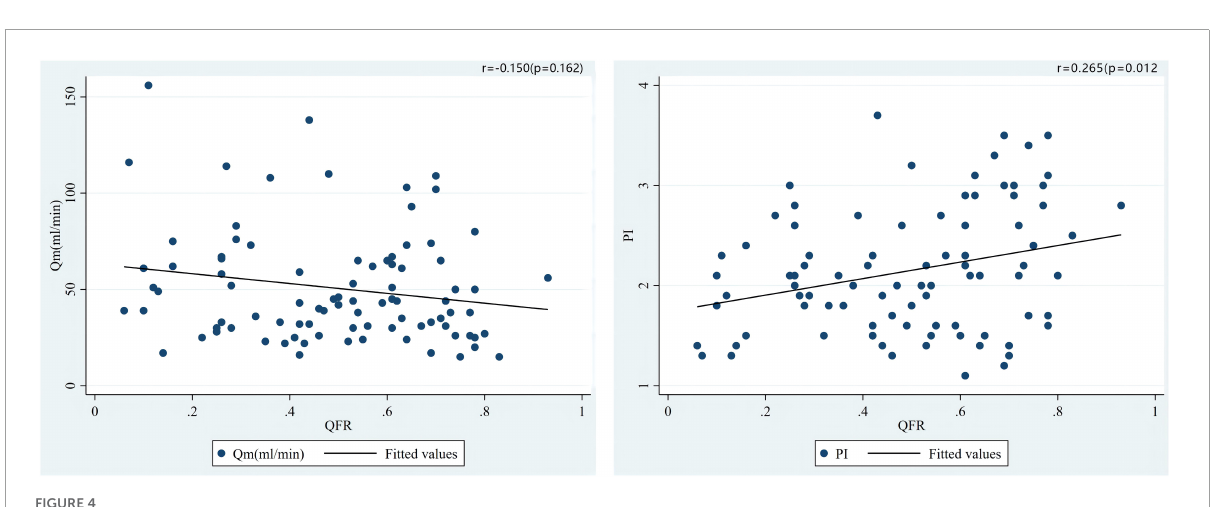
group: 1.4 (0.5), V2 group: 1.8 (0.8); the number of